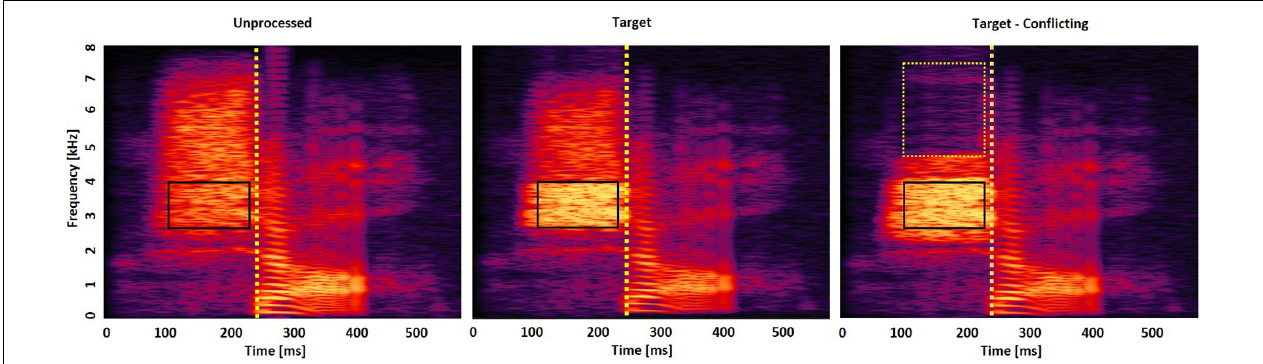
FIGURE 1 | Spectrogram of / S a/ consonant under the three signal processing conditions: unprocessed (left panel) , intensified target frequency and time ranges by + 6 dB gain (middle panel), and the combined intensified target ranges and removed conflicting ranges (right panel) . Solid squares indicate the target frequency and time ranges, whereas the dotted square indicates the conflicting frequency and time ranges. Dotted vertical lines indicate an onset of the vowel /a/.